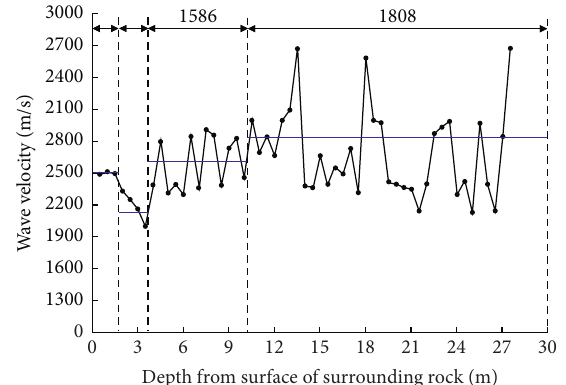
Figure 14: In situ measured result of acoustic wave testing at YK235 +280 in the right